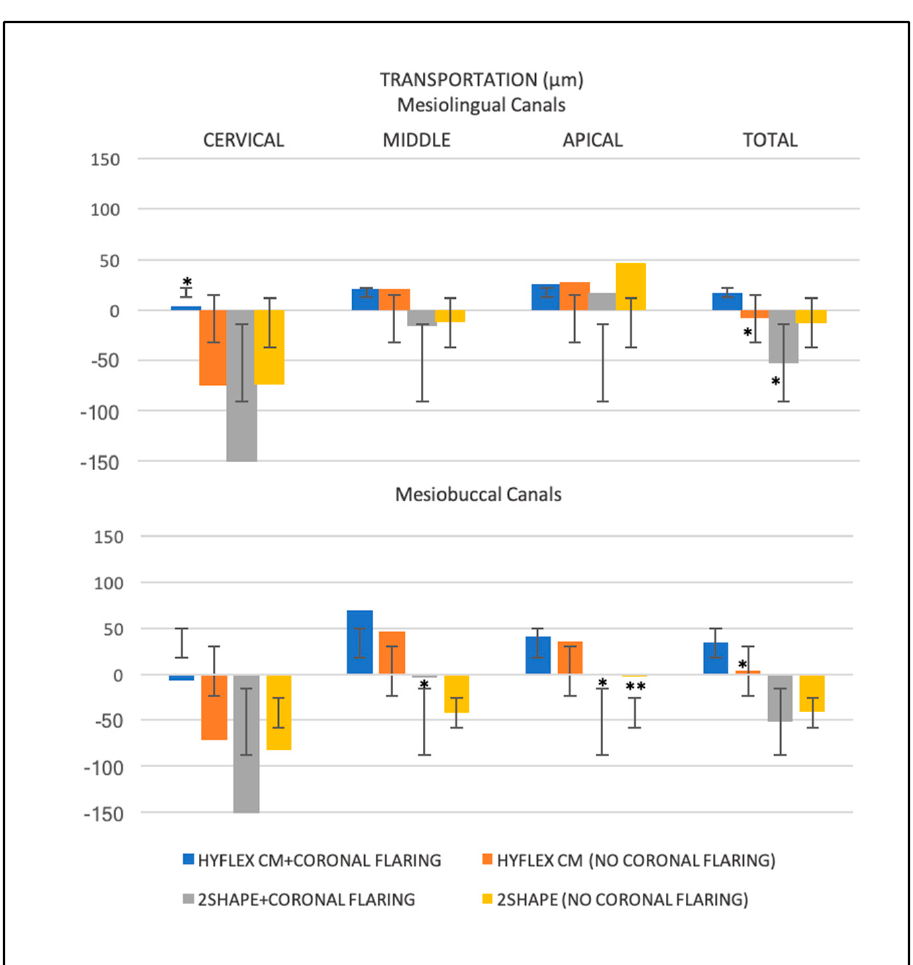
Figure 2. Histogram of the mean values (µm, micrometers) and standard deviations (I) of the root canal transportation for each instrumentation procedure at different anatomical thirds. *, ** indicate a statistically significant difference between the different instrumentation procedures for the same anatomical third.